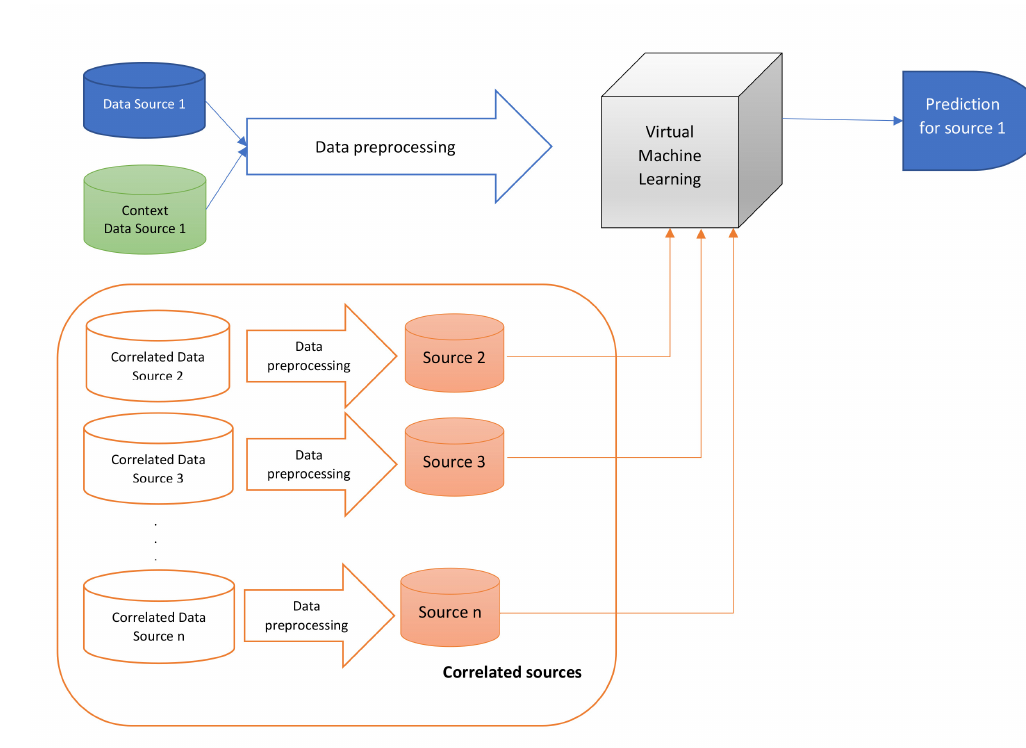
Figure 1. Innovation: Context-Aware Data Mining (CADM) and Collaborative Data Mining (CDM) combined process overview, influenced by Reference